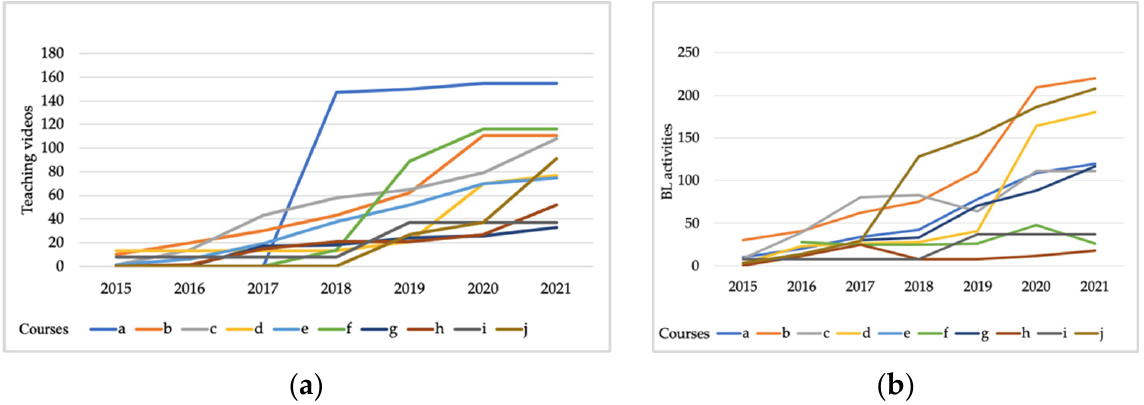
Figure 2. ( a ) Iteration of the teaching videos; ( b ) iteration of BL activities. Note that course activities mainly include watching videos, reading documents, participating in course discussions, completing tests and assignments, participating in self- and peer assessment, etc.